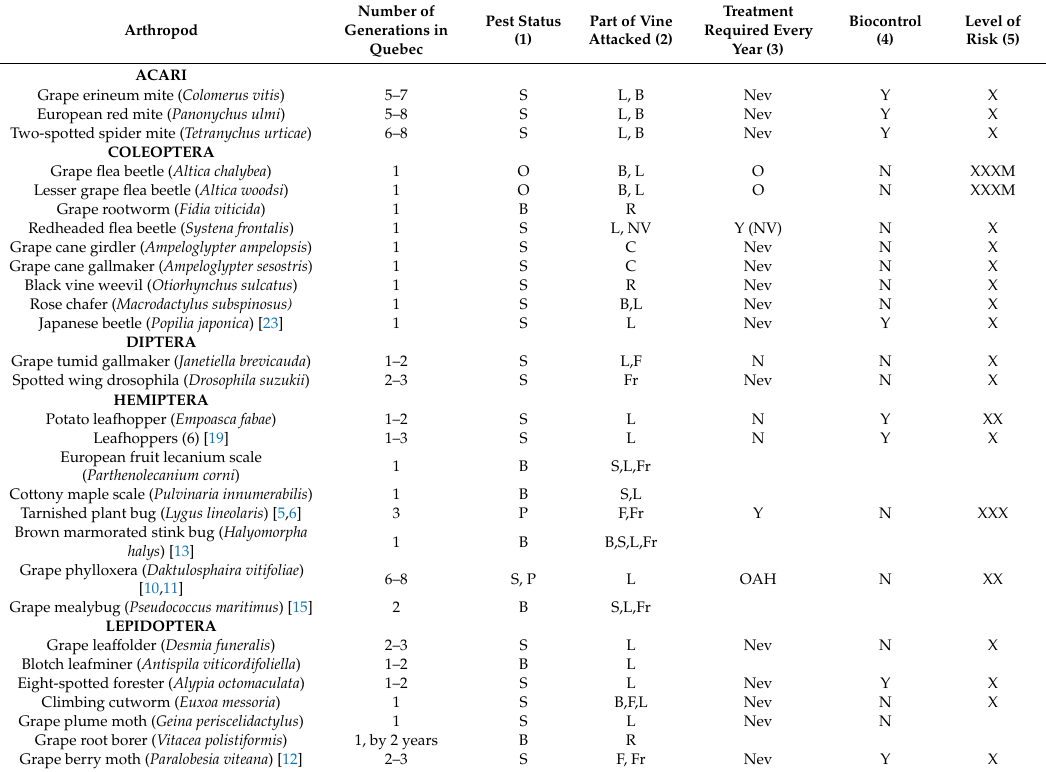
Table 1. Biological and agronomical attributes of the main arthropods of Quebec vineyards.